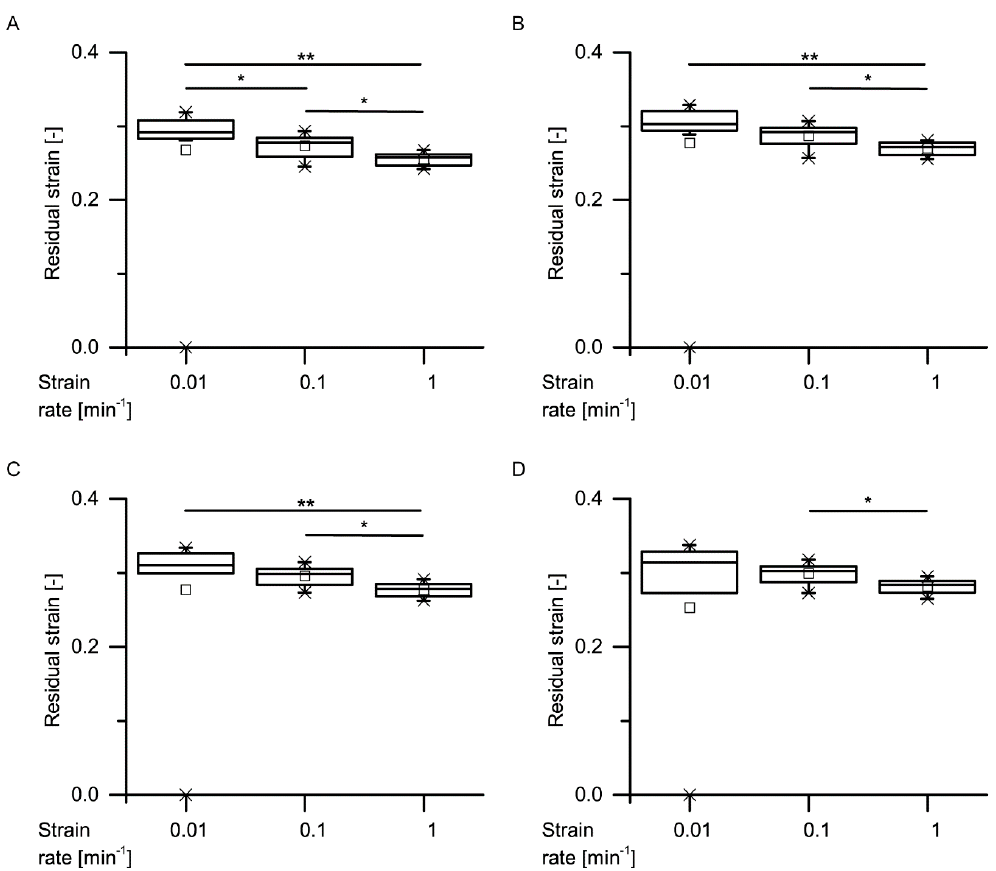
Figure 12. Residual strains of the first ( A ), second ( B ), third ( C ) and fourth ( D ) cycles of the quasistatic cyclic compression tests with unchanged maximum compression, at several strain rates (statistical test: Kruskal–Wallis test; n = 10 for each group). Significant differences are marked by asterisks, with the levels of significance indicated as follows: * p < 0.05, ** p < 0.01.